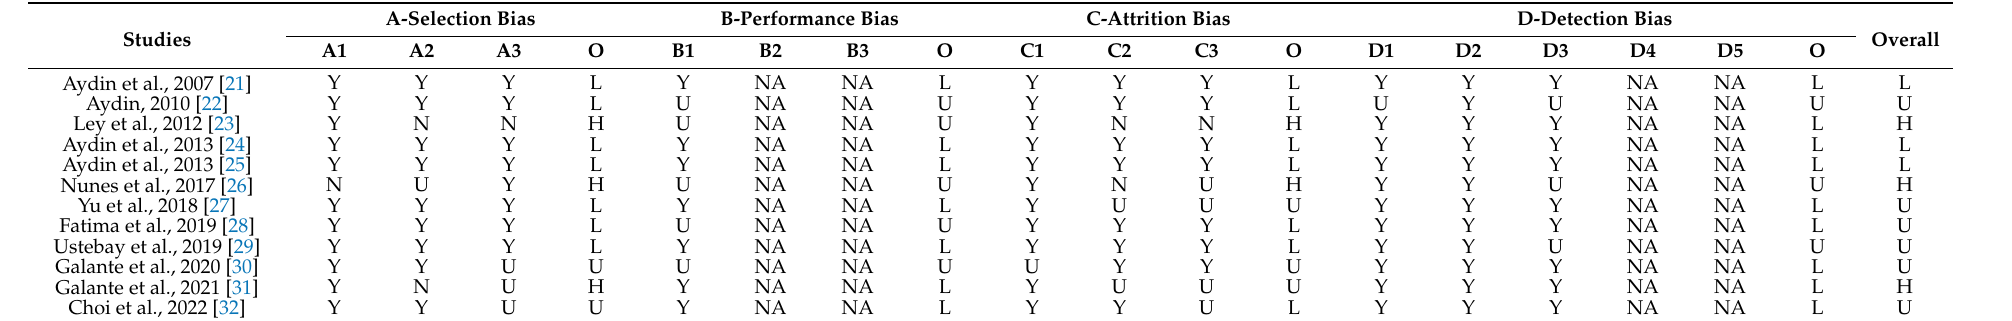
Table A1. Evaluation of risk of bias in studies assessing the relationship between concentrations of metabolic hormones in human milk and gestational diabetes